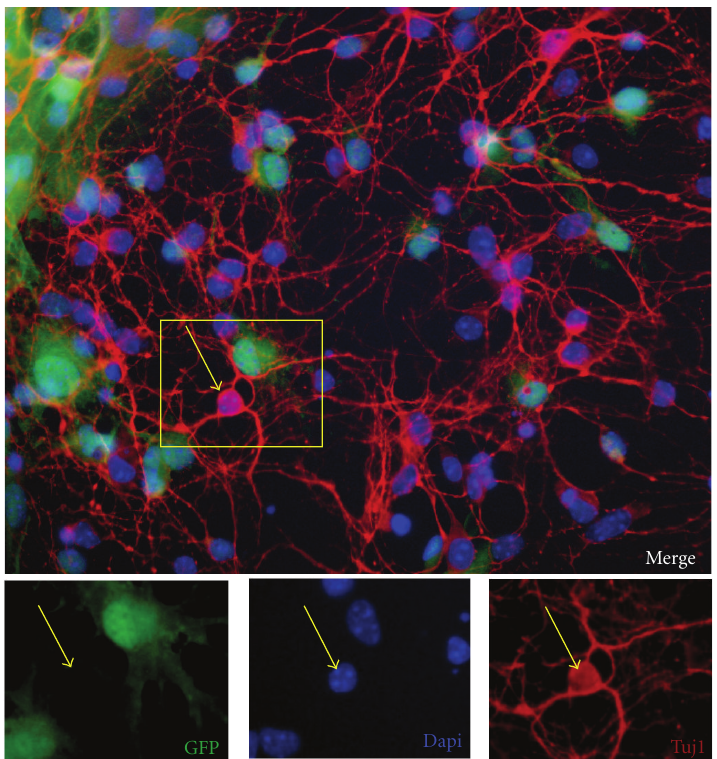
Figure 2: Neuronal marker expressed by bone marrow stromal cells. Bone marrow stromal cells were cocultivated for 5 days with GFP- positive cerebellar granule neurons (green). Immunofluorescence labeling showed that beta-III tubulin recognize by Tuj1 antibodies (red) was expressed by about 20% of bone marrow stromal cells (GFP-negative or nongreen cells) [6,